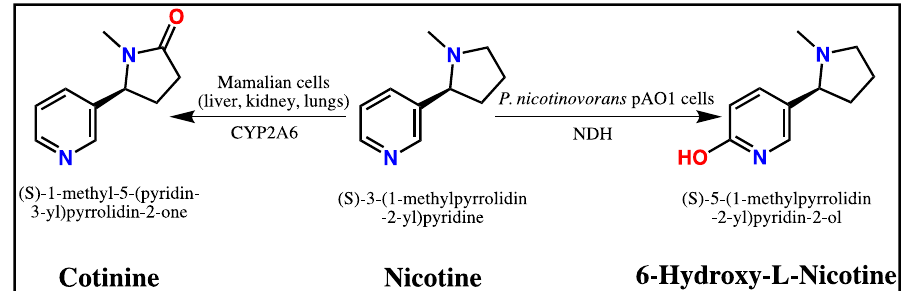
Figure 1. The comparison of the chemical structures of nicotine and nicotinic derivatives: cotinine and 6-hydroxy-L-nicotine (CYP2A6—Cytochrome P450 2A6; NDH—nicotine ‐ dehydrogenase).